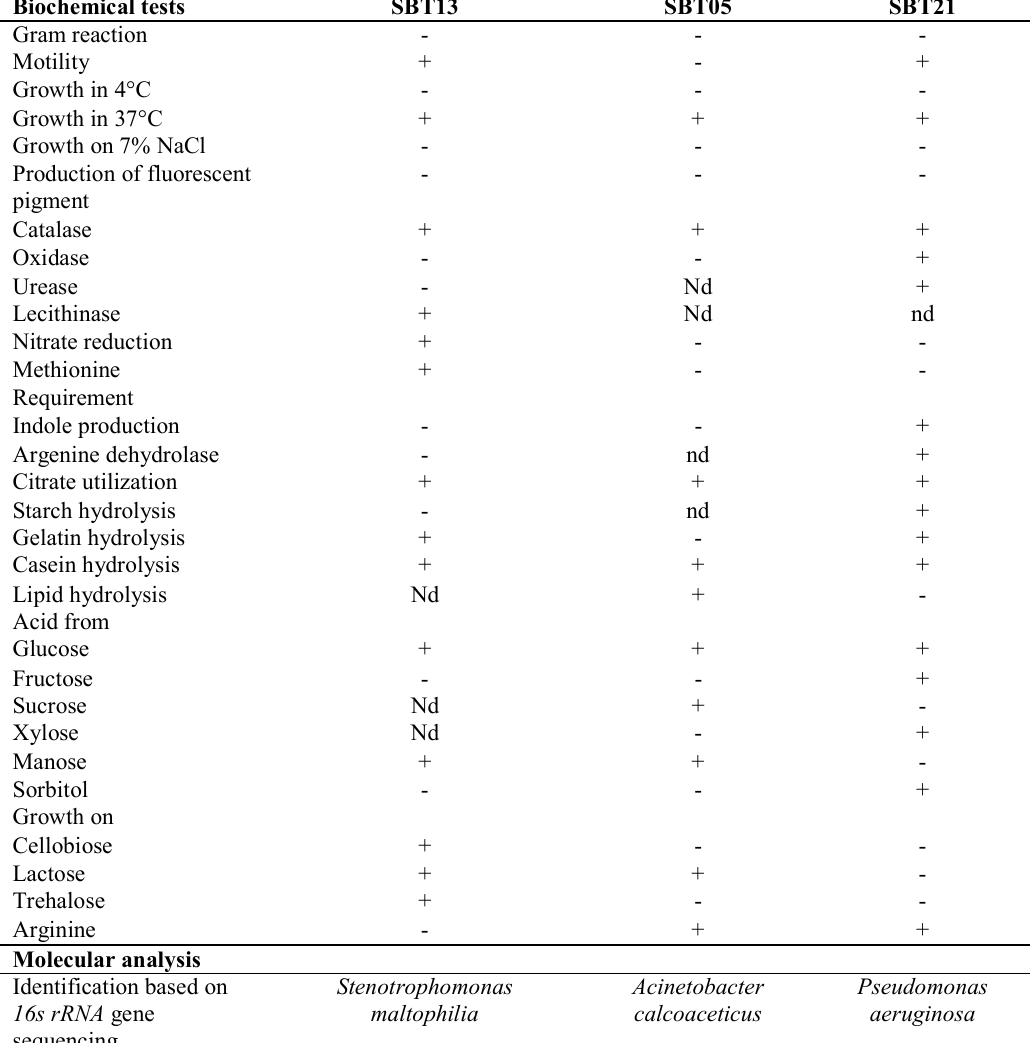
+ representing the positive reaction, and – shows the negative reaction. nd: not done. The experiment was repeated twice for each representative